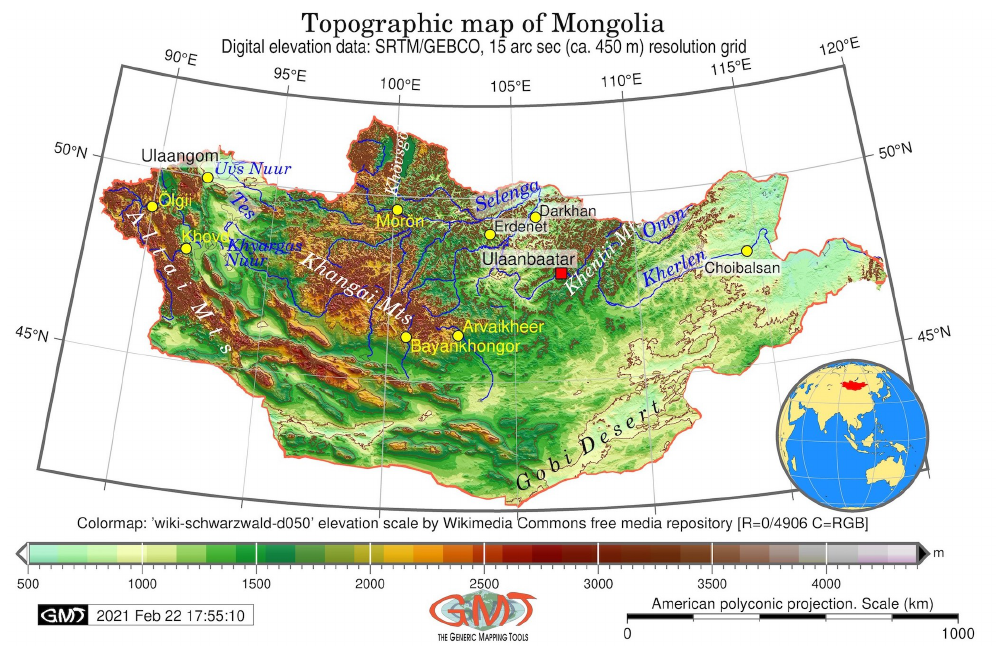
Figure 1. Topographic map of Mongolia. Mapping: GMT by script available in Appendix